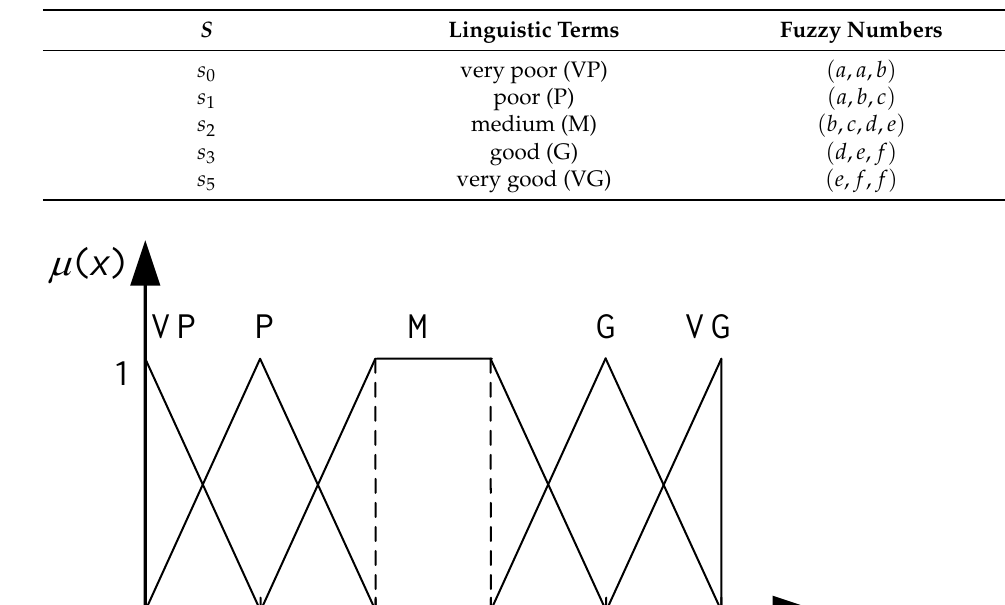
Table 1. Linguistic terms and fuzzy numbers.